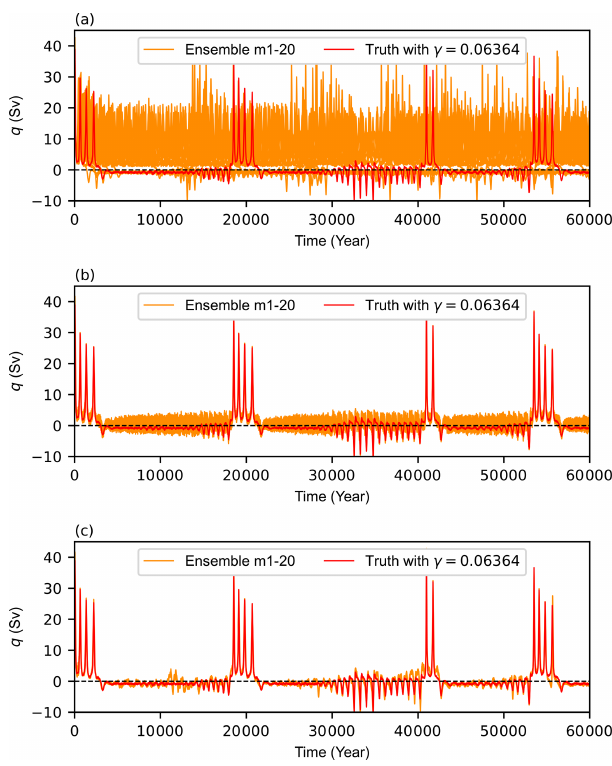
Figure 9. Time series of the meridional overturning circulation q in the “truth” simulation with γ = 0 . 06364 (red) and the individ- ual ensemble members (orange) in the free model control ensemble simulations (a) without data assimilation and parameter estimation, (b) with data assimilation or (c) with data assimilation and param- eter estimation using erroneously guessed γ values with a Gaus- sian perturbation that has a mean value of 0.070004 and a standard deviation of 10% times the standard value. The dashed black line denoting q = 0 is a division line between two equilibrium